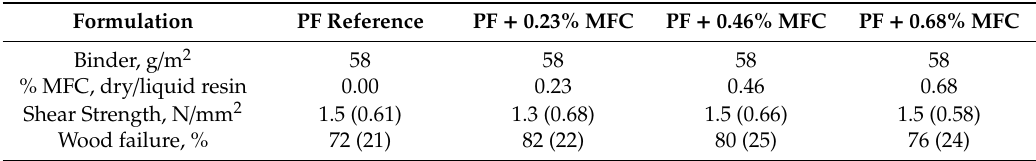
Table 13. Plywood panels analysis, MFC 10% increasing levels, Approach